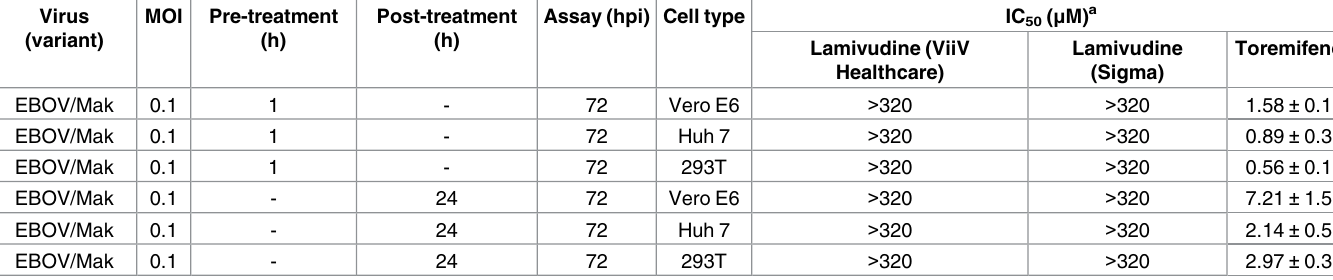
EBOV, Ebola virus; hpi, hours post-inoculation; IC 50 : 50% inhibitory concentration; Mak, Makona; MOI, multiplicity of infection. a IC 50 values are mean values ± the standard deviation from 4 dose-response